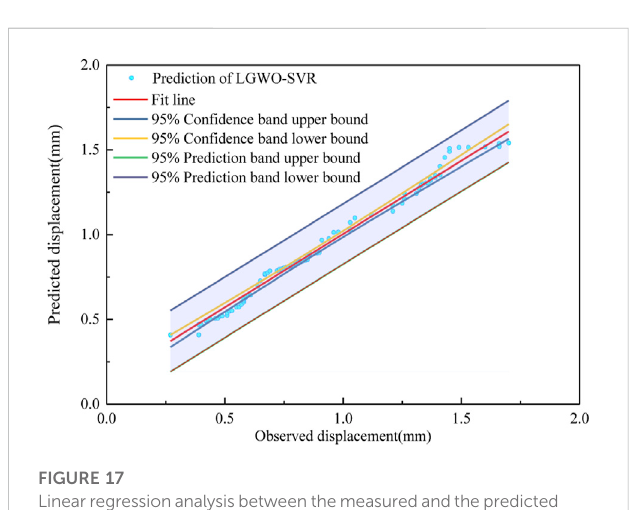
FIGURE 17 Linearregressionanalysisbetweenthemeasuredandthepredicted